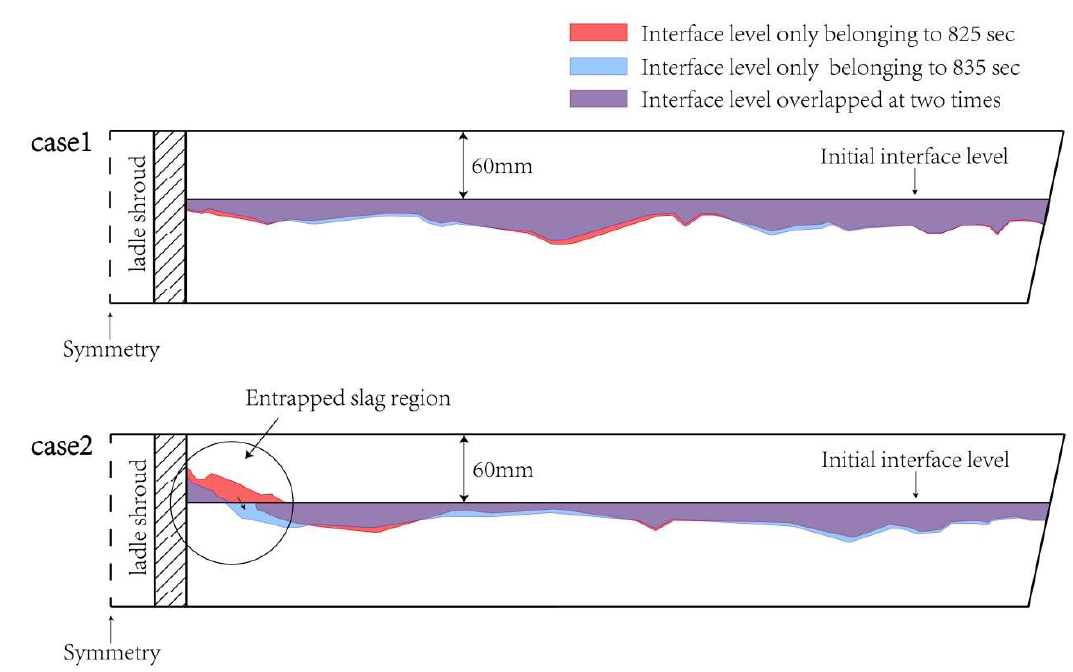
Figure 11. The change of steel-slag interface in two cases from 825 s to 830 s.